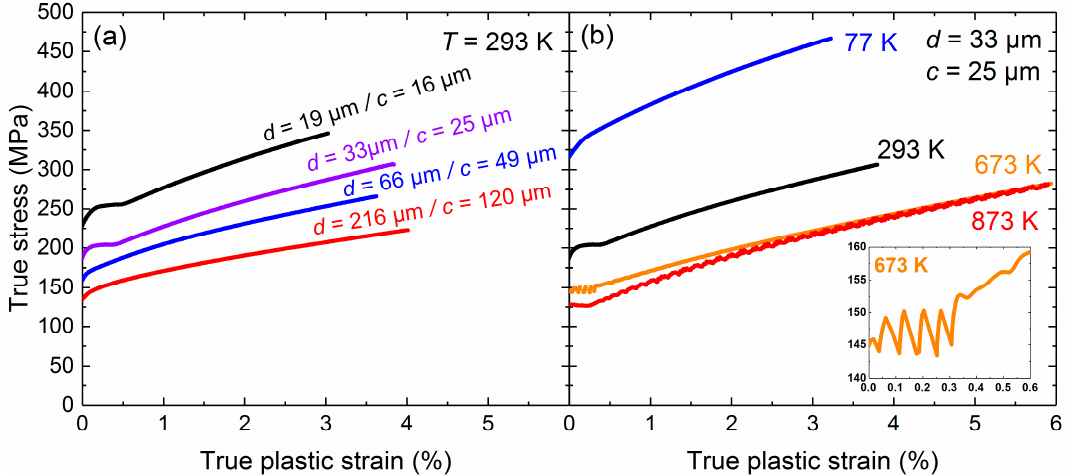
Figure 5. Representative true stress–true plastic strain curves obtained in compression of MnFeNi at ( a ) room temperature with different grain and crystallite sizes and ( b ) for a grain and crystallite size of 33 and 14 µ m, respectively at different temperatures. The inset in ( b ) shows a serrated flow after yielding for the curve obtained at 673 K.